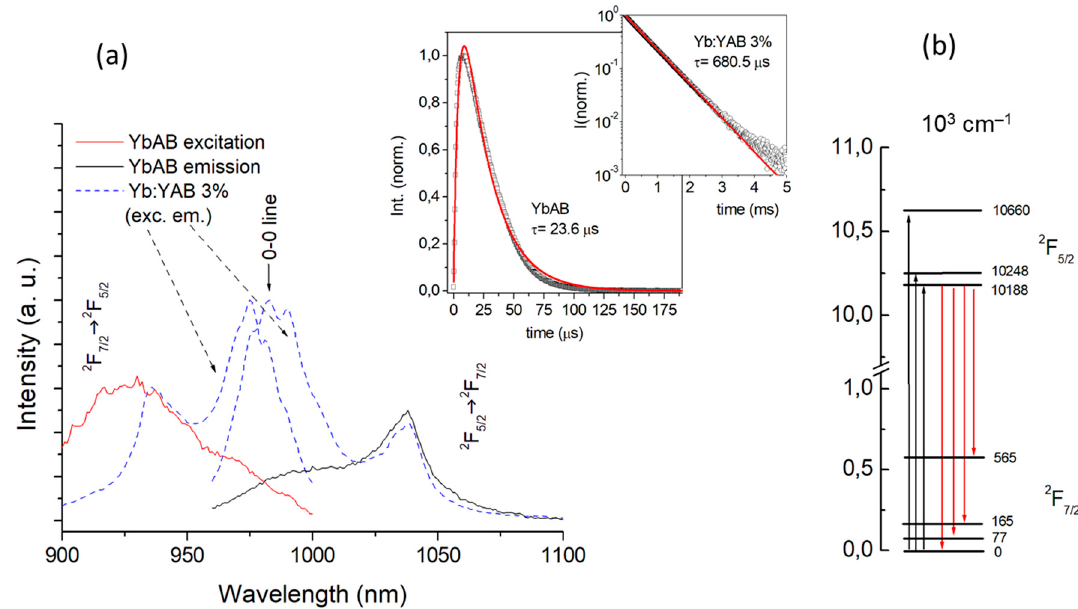
Figure 8. ( a ) Excitation (monitored wavelength: 1038 nm) and emission (excitation at 940 nm) spectrum of YbAB. Inset: decay profiles of the Yb:YAB and YbAB emission. ( b ) Energy levels scheme and electronic transitions.